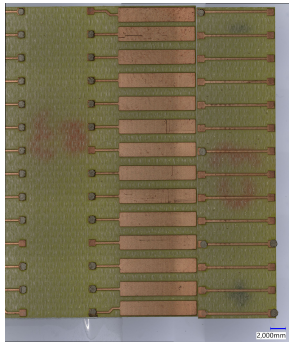
Figure 13. After the shear test: conductive adhesive is observed remaining completely either on the Cu-Pad of test chip or on the Cu-pad of the test